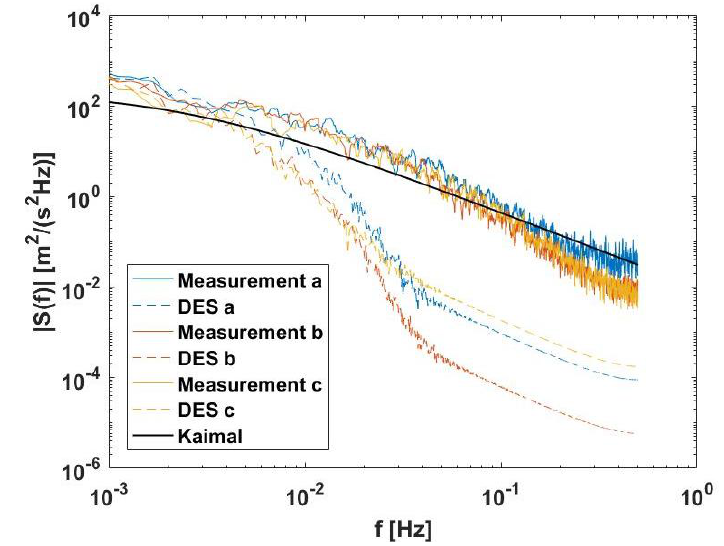
Figure 17. Power density spectra for the Lidar and the DES model at distances ( a ) 1000m, ( b ) 600m and ( c ) 400m from the Lidar, and the estimated Kaimal spectrum during 14 June 2015 1:00 p.m. to 10:30 p.m.